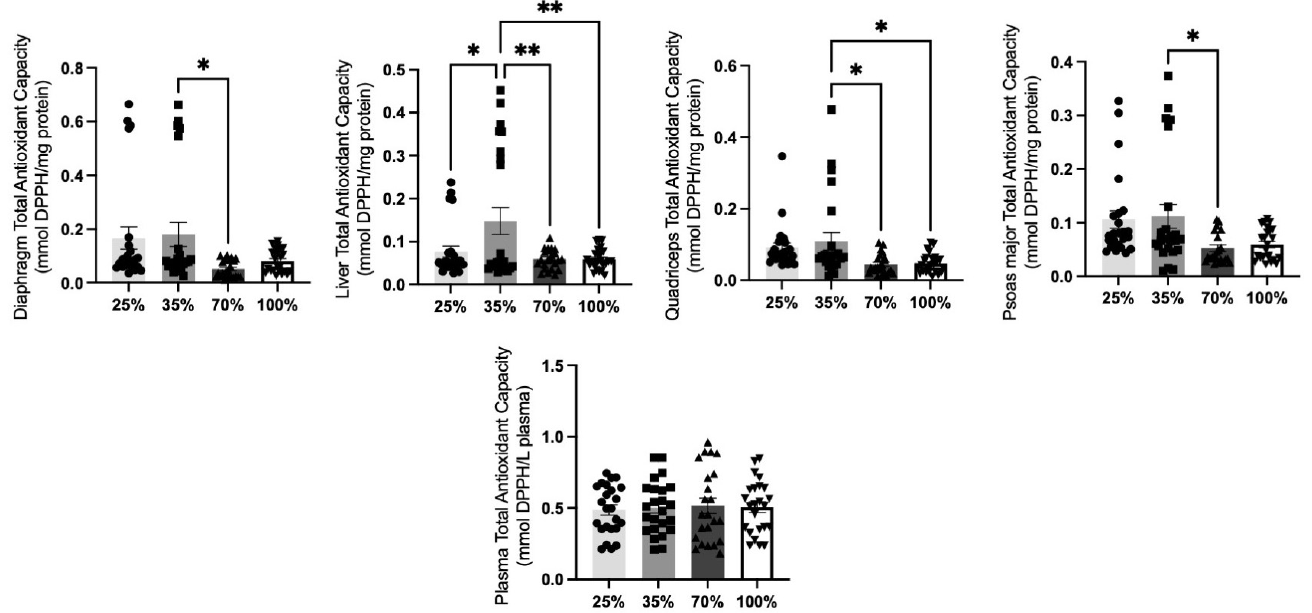
Figure 8. TAC levels at all 4 d.s. of lambs. * denotes significant difference with p < 0.05, ** denotes significant difference with p < 0.01.